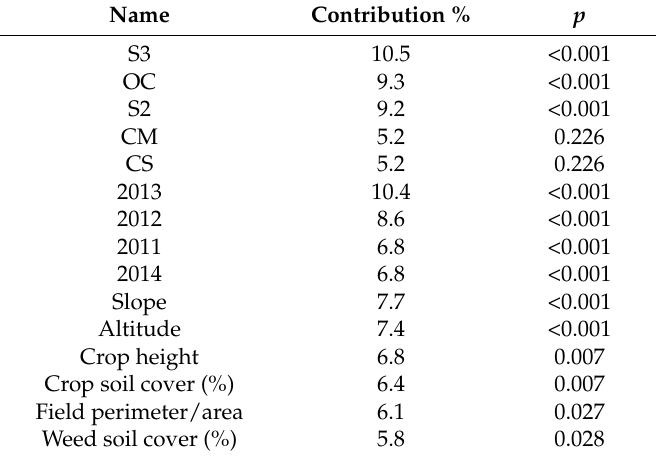
Table 6. Results of the Canonical Correspondence Analysis (CCA). CM: cereal monocrop, CS: cereal